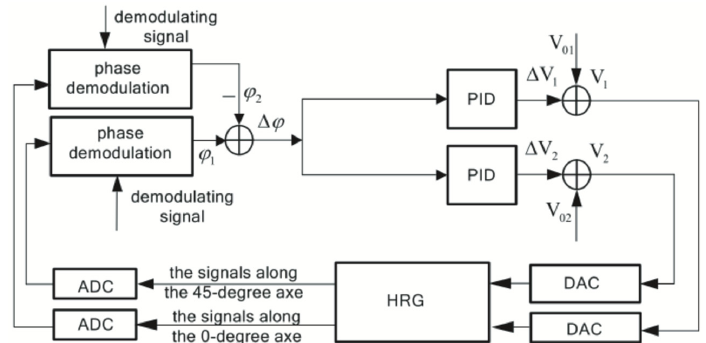
Figure 14. Block diagram of the orthogonal error from the National University of Defense Technology.